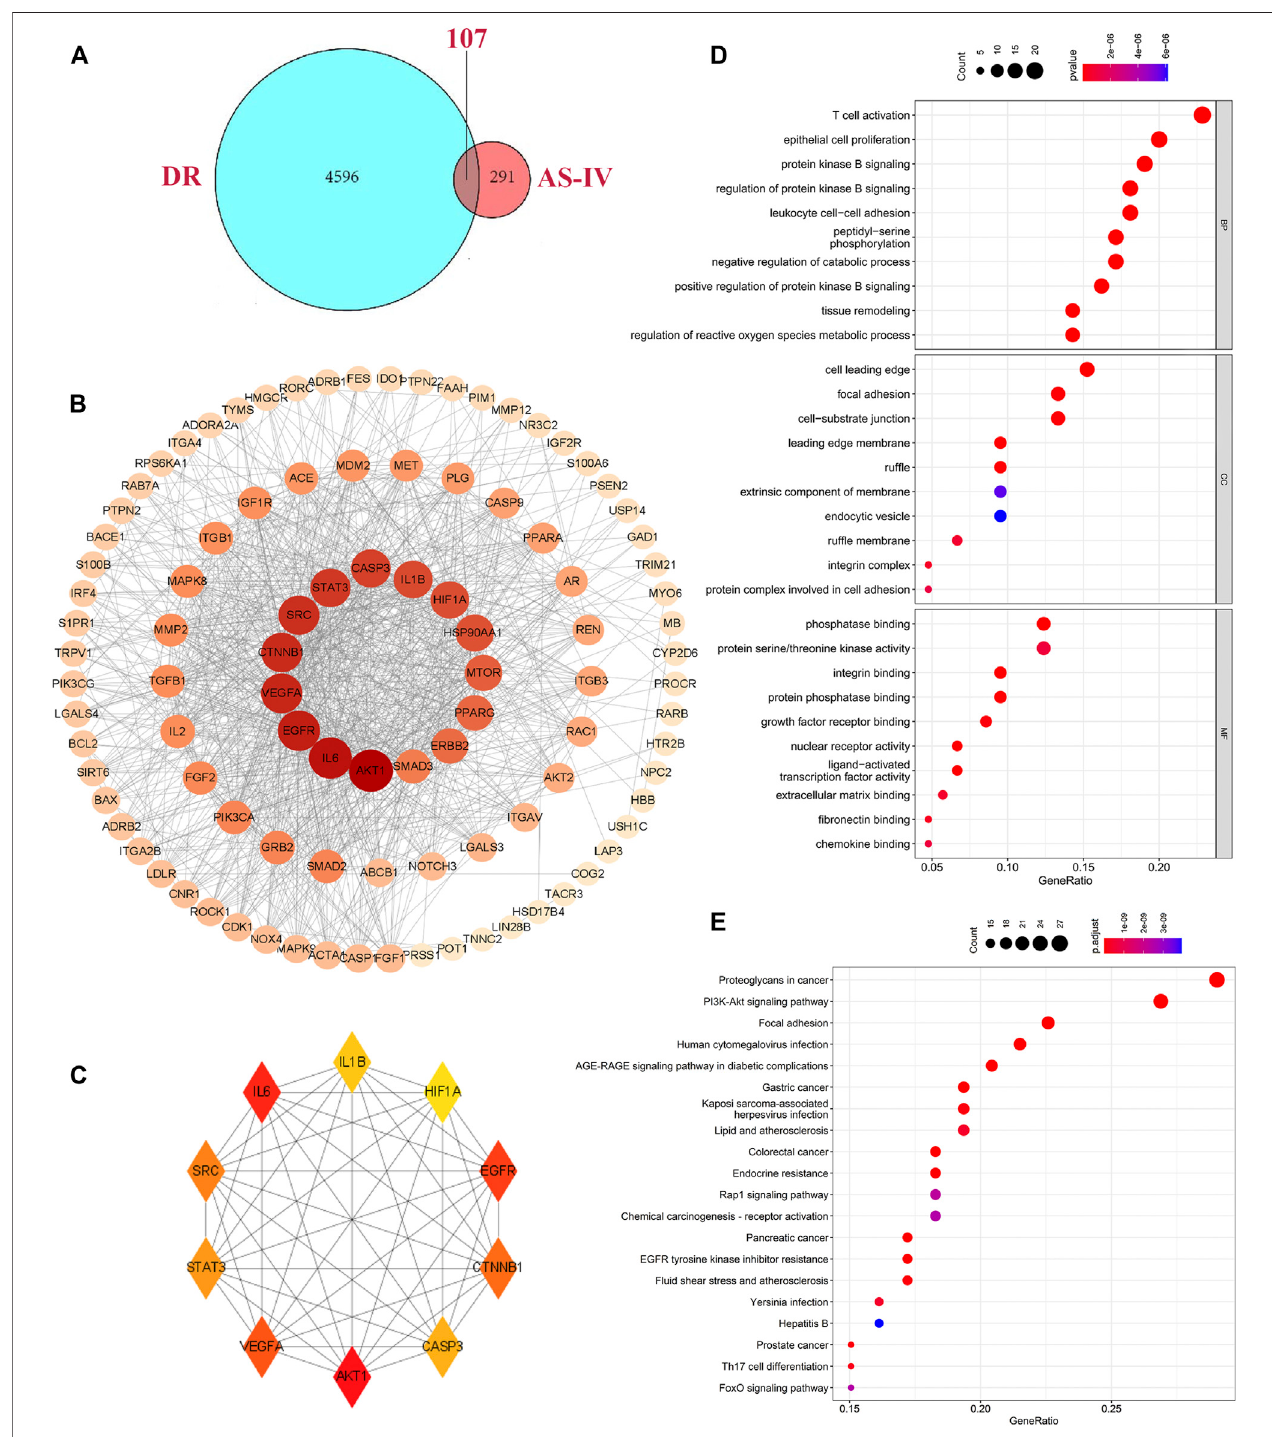
FIGURE 5 | Hub genes identi fi cation and biological function analysis. (A) Intersection of targets shared by AS-IV and DR. The blue and red ellipses represent the identi fi ed DR and AS-IV targets respectively, and the middle part represents the common targets of AS-IV and DR. (B) PPI networks were visually analyzed using Cityscape 3.8.2 software. The larger the node area, the darker the color, the more important it is in the network. (C) The top 10 key genes obtained by degree value method. Each node represents a protein, and each edge represents the relationship between two proteins. The larger the node in the PPI network the darker the color, the more the node protein will interact with the surrounding proteins. (D) GO enrichmentanalysisof hub genes, includingthe BP, CC and the MF items. (E) KEGG pathways terms involved by hub genes. DR, diabetic retinopathy; AS-IV, astragaloside IV; BP, biological processes; CC, cellular component; MF, molecular function.